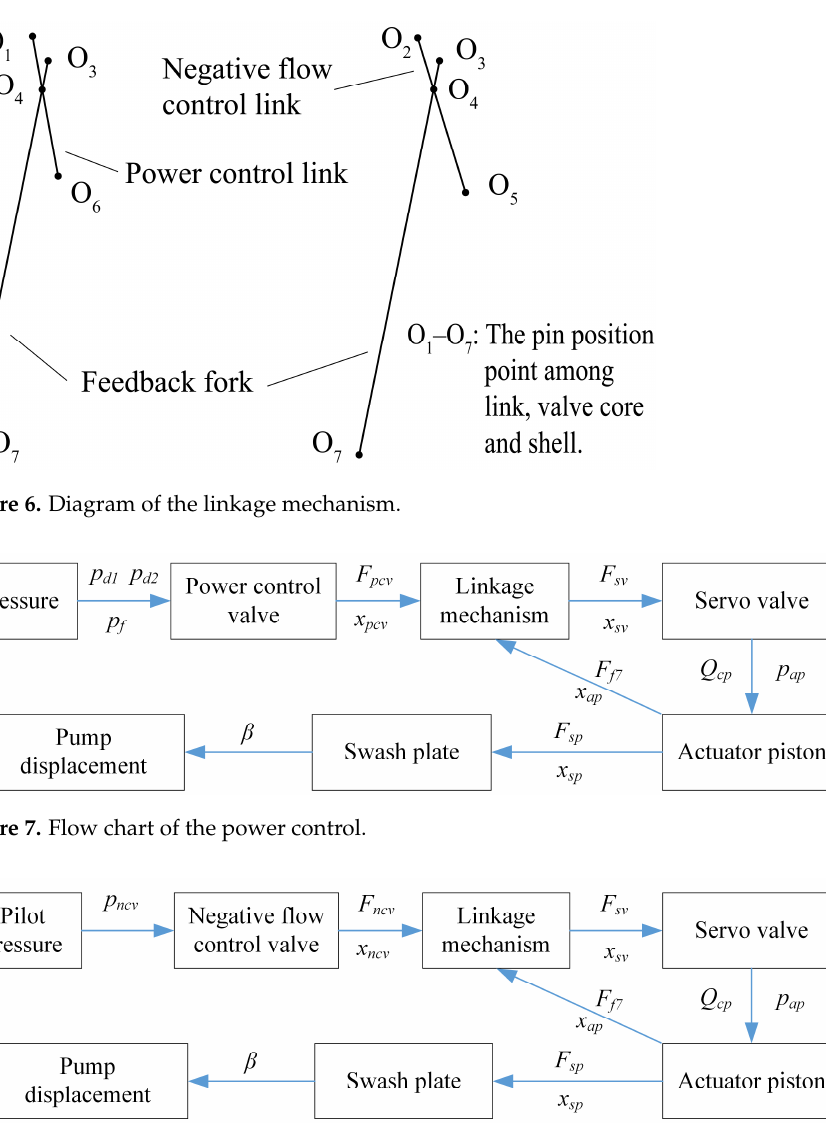
Figure 8. Flow chart of the negative flow control. In the process of power control, according to the motion relationship between the power control valve, the servo valve, and linkage mechanism, the motion equation of servo valve is expressed